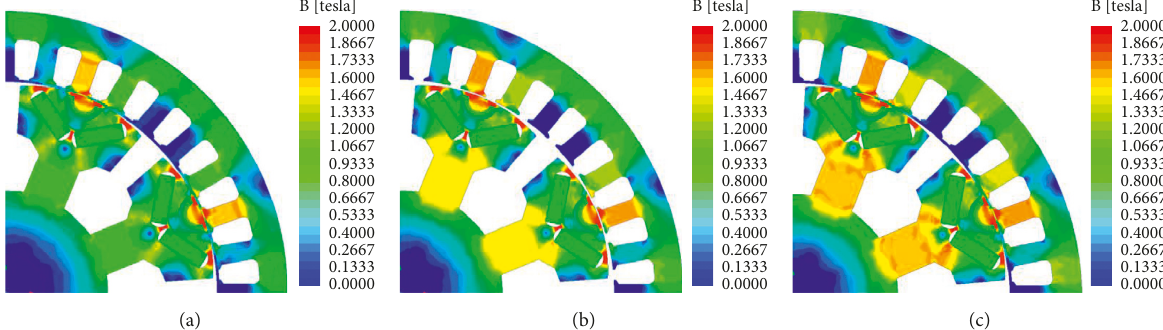
Figure 3: Cloud diagrams of magnetic flux density with different excitation currents: (a) when the excitation current is − 2A; (b) when the excitation current is 0A; (c) when the excitation current is 2A.